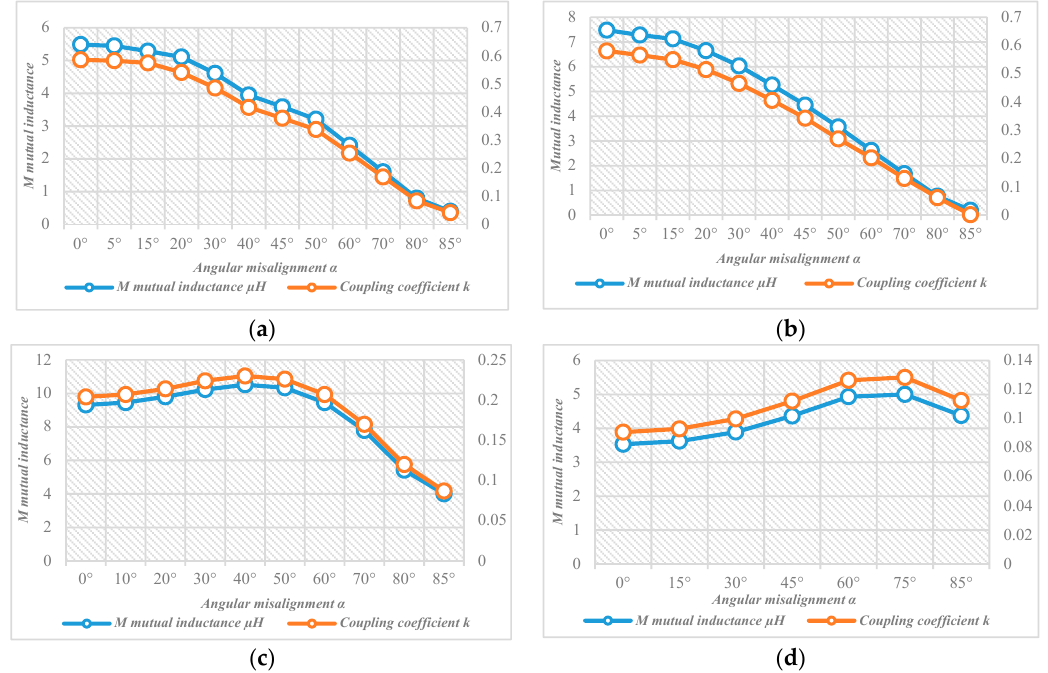
Figure 10. The mutual inductance and coupling coefficient: ( a ) equator windings; ( b ) hemisphere windings; ( c ) double-layer windings; ( d ) optimal model.